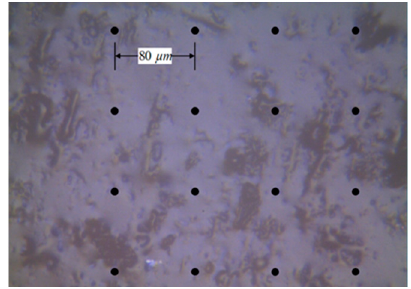
Figure 6. The specimens of the nanoindentation test.